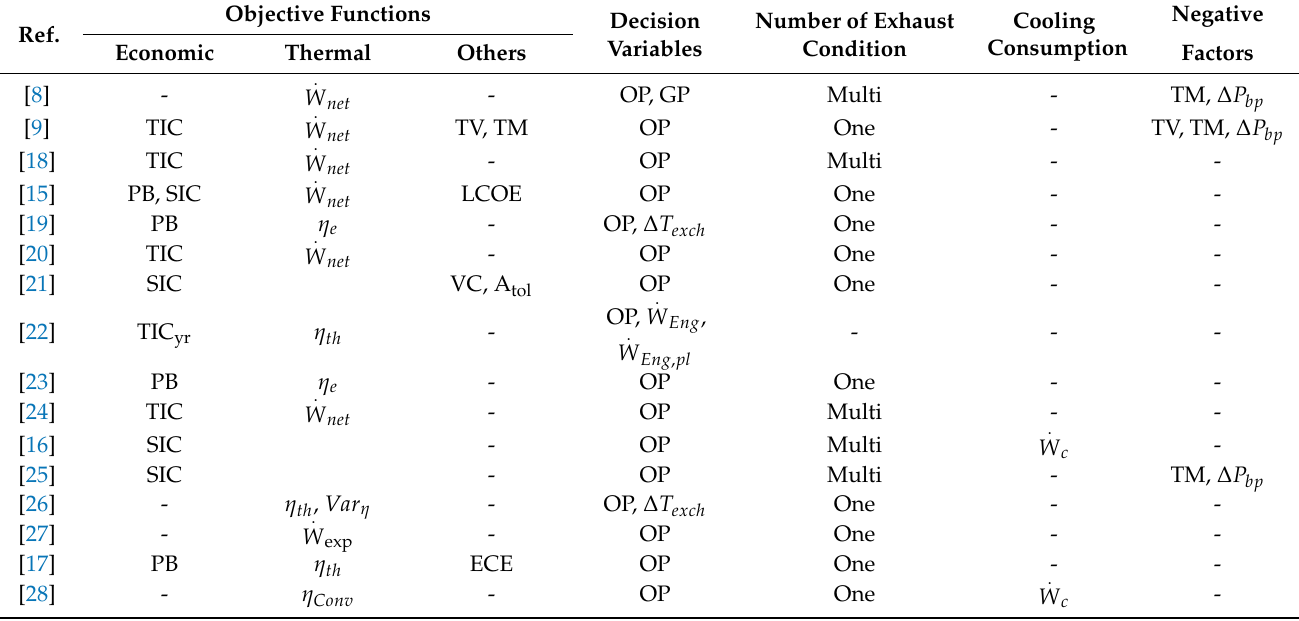
Table 1. The optimization studies of ORC applied to waste heat recovery of ICEs. OP represents the operating parameters, GP represents the geometric parameters, LCOE is the levelized cost of energy, ECE is the emissions of CO 2 equivalent, ∆ T exch is the pinch-point temperature difference of a heat exchanger, and Var η is the variance of thermal efficiency.